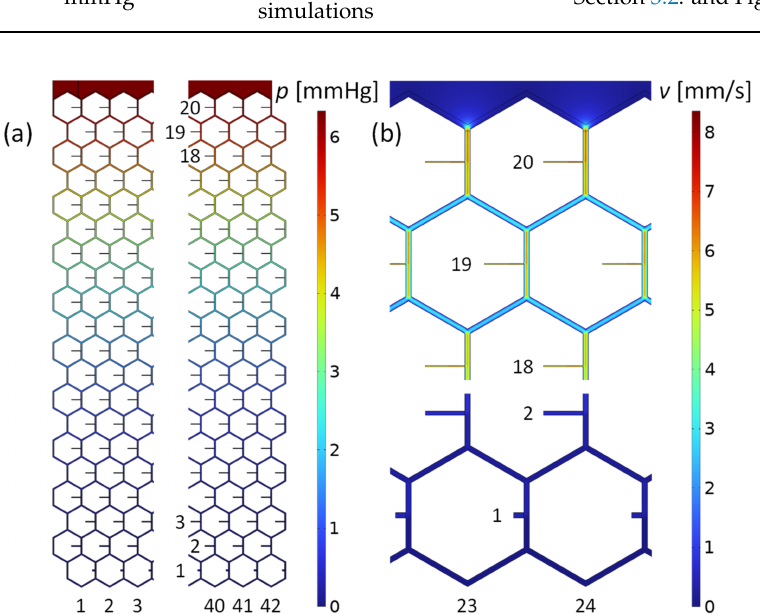
Figure 4. Pressure and flow velocity field in the microchannel mesh computed with the program COMSOL. The boundary conditions were the inlet flow rate of 1.7 µ L 0 mmHg at each orifice. ( a ) Pressure distribution in the stent of the leftmost and rightmost part of the mesh. The maximum value is 6.3 mmHg at the inlet, above row 20. ( b ) Flow velocities in the midplane of the meshwork. Shown are flow details at top and bottom of the stent, along the centerline of the honeycomb